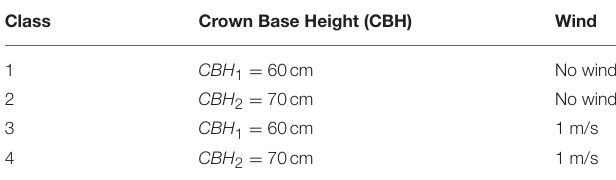
TABLE 1 | Table of experiment